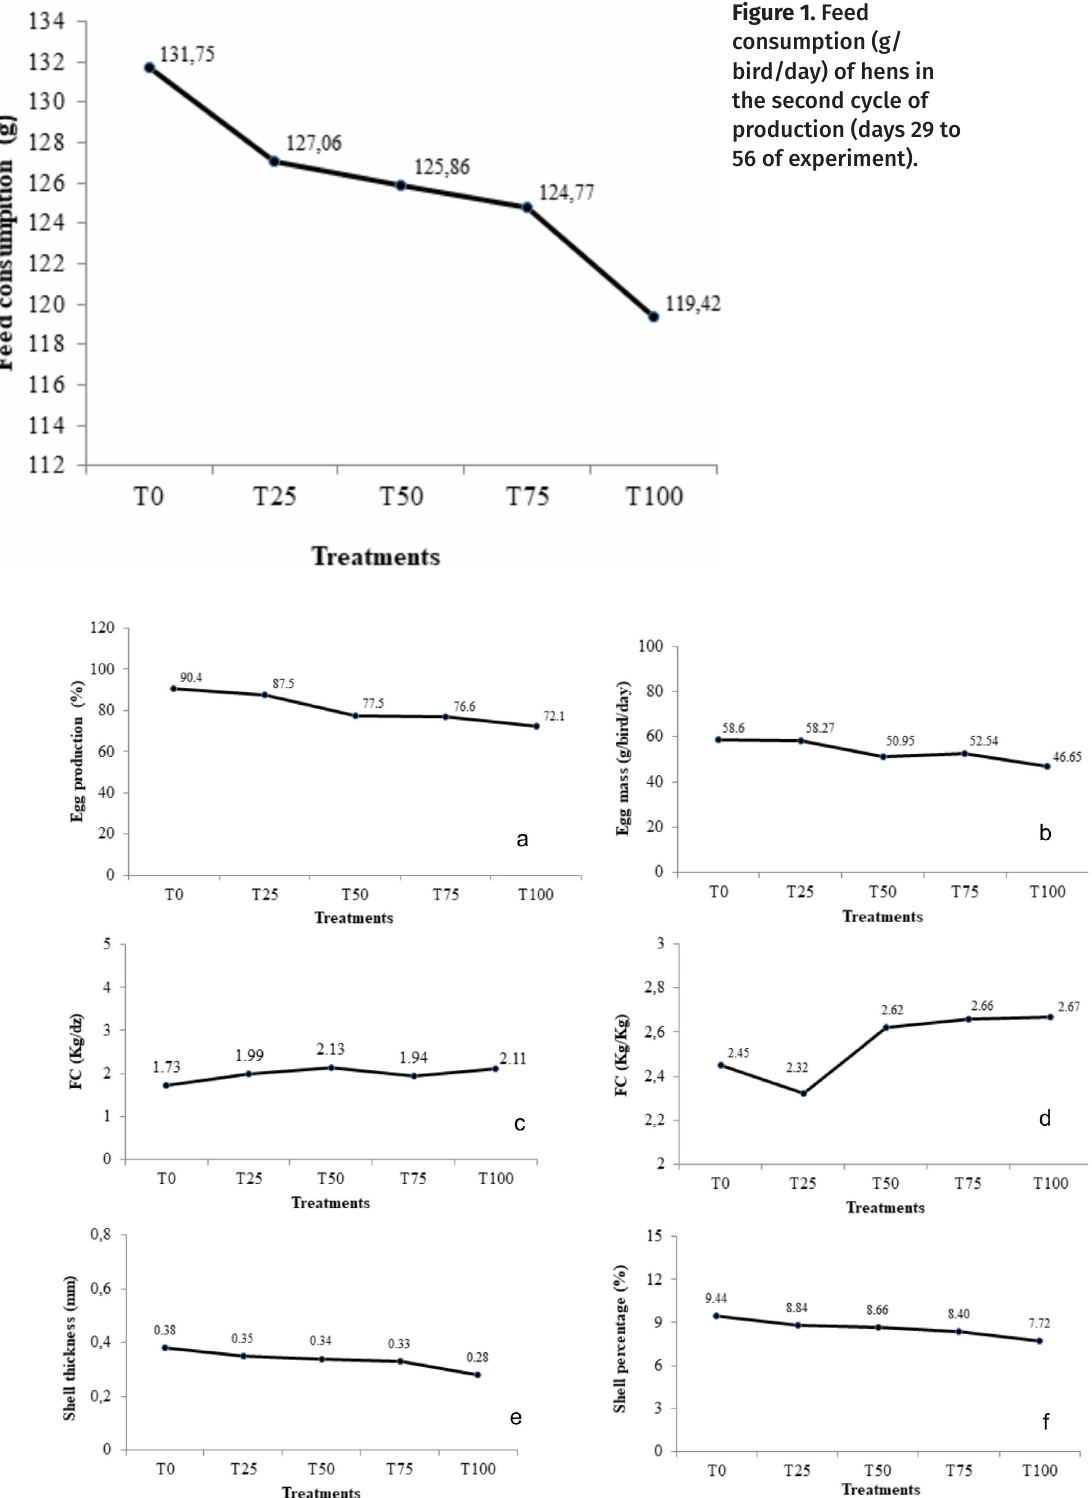
Figure 2. Eggs production (a); Egg mass (b); Feed conversion kg/dz (c); Feed conversion kg/kg (d); shell thickness (e) and egg shell percentage (f) third cycle of production (day 57 to 84 of